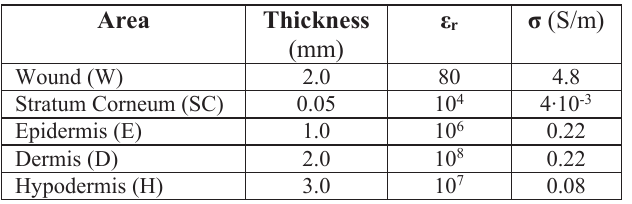
Tab.1: Summary of modeling parameters used in different regions of figure 4. ε r is the relative dielectric permittivity and σ is the electrical conductivity.